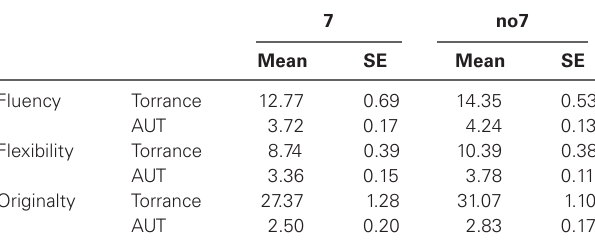
Table 2 | Means and Standard Error (SE) of the two creativity tasks used: AUT and Torrance